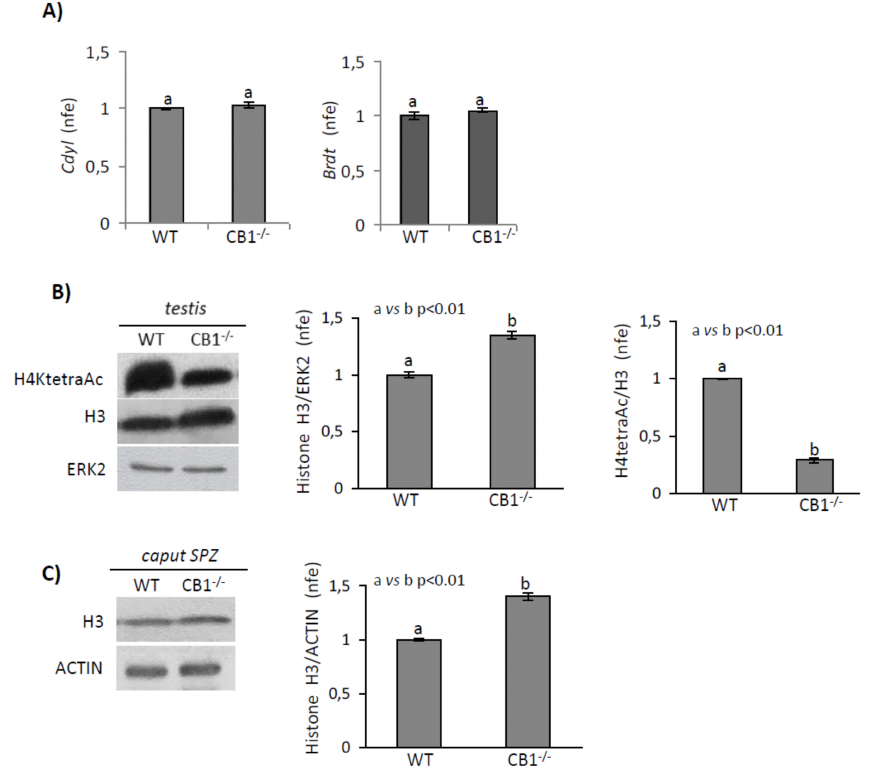
Figure 5. RTqPCR analysis of Cdyl and Brdt i n testis of WT and CB1 - / - mice ( A ). Transcript amounts was reported as normalized fold expression (nfe) relatively to Rps18 gene. Western blot analysis of ( B) Histone H4tetraAc and Histone H3 in testis and ( C ) Histone H3 in caput SPZ of WT and CB1 - / - mice. H4tetraAc and H3 amount was quantified by densitometry analysis, normalized against ERK2 (for testis) or ACTIN (for caput SPZ) signals and expressed as a fold change of OD values. All data are reported as mean values ± S.E.M. Graphs were representative of six or seven testis from six / seven di ff erent animals / genotype ( n = 6 or 7 animals for each genotype in triplicates). Di ff erent letters indicated statistical significance ( p < 0.05 or p <